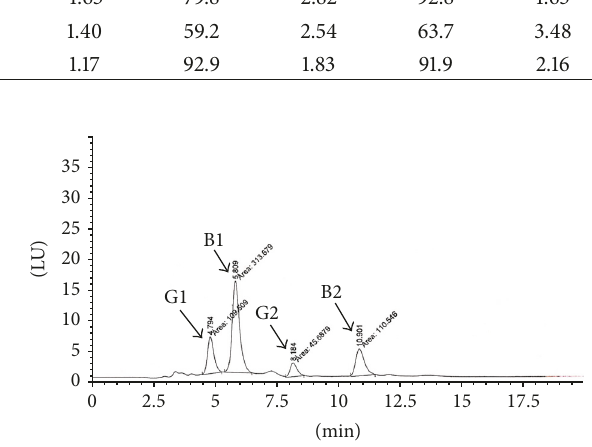
Figure 1: HPLC chromatogram of aflatoxin Standards.